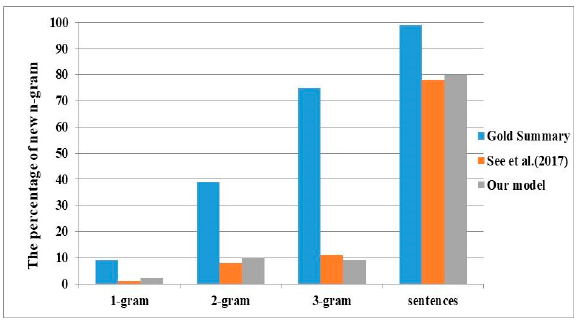
Figure 7. The percentage of new n-grams for DUC 2004. Larger percentage indicates stronger abstraction.